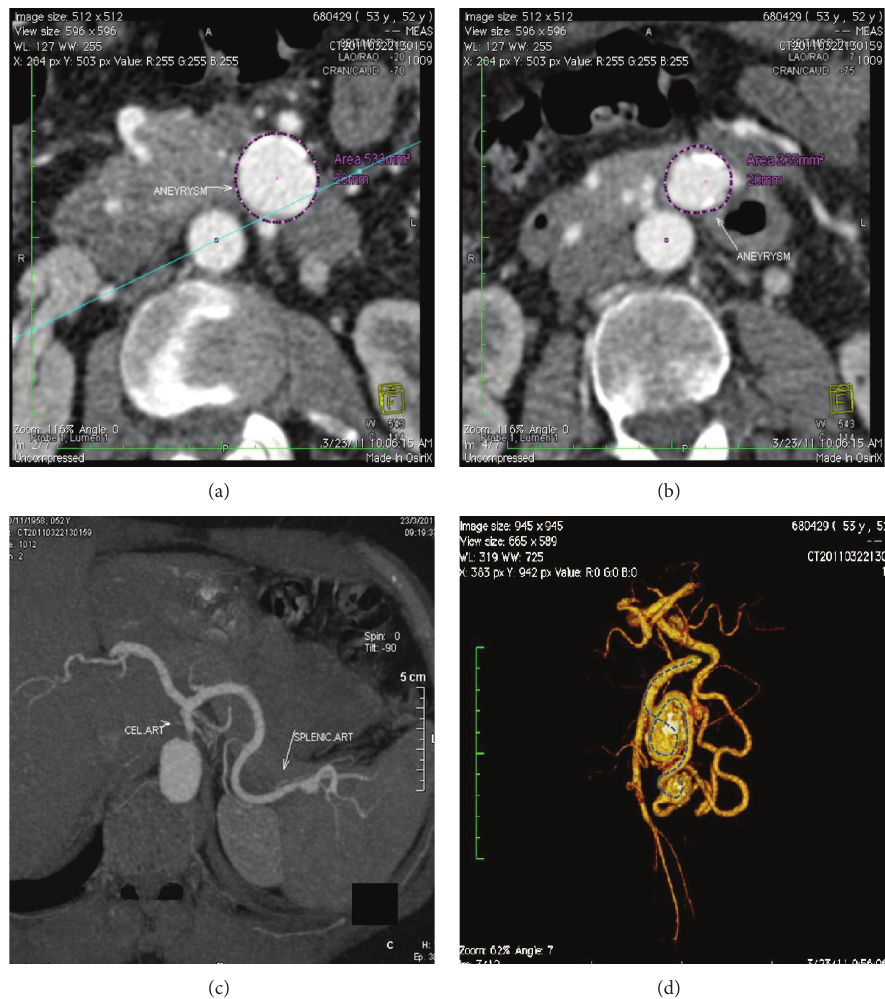
Figure1:(a,b)IntrapancreaticaneurysmsoftheIPDAonCTA.(c)Medianarcuateligament-syndrome-likestenosisoftheceliactrunkorigin. (d) 3D volume rendering image processing provides closeup of the superior mesenteric artery, both IPDA aneurysms and their connecting